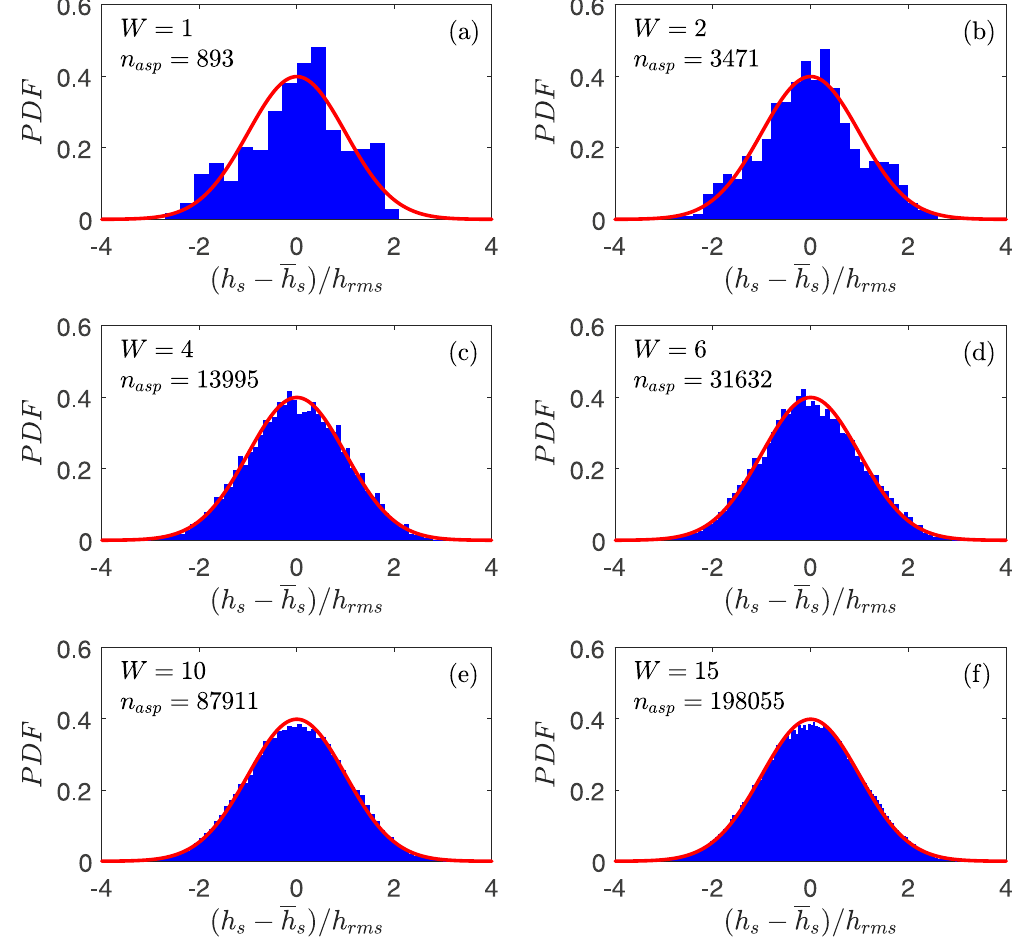
Figure 1. Probability density function of the summit height. The surface has H = 0.8, ζ = 64, λ 0 = 100 µ m and from ( a ) to ( f ) respectively = . W [1, 2, 4, 6, 10, 15] n